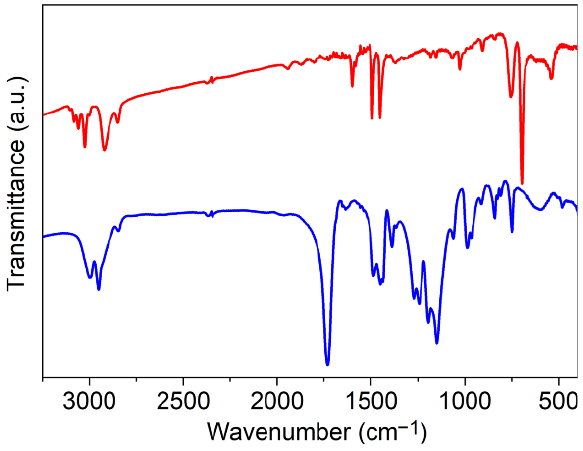
Figure A6. FTIR spectra of PS /γ -Fe 2 O 3 (red) and PMMA/γ -Fe 2 O 3 (blue) displaying the characteristic bands of the polymers.